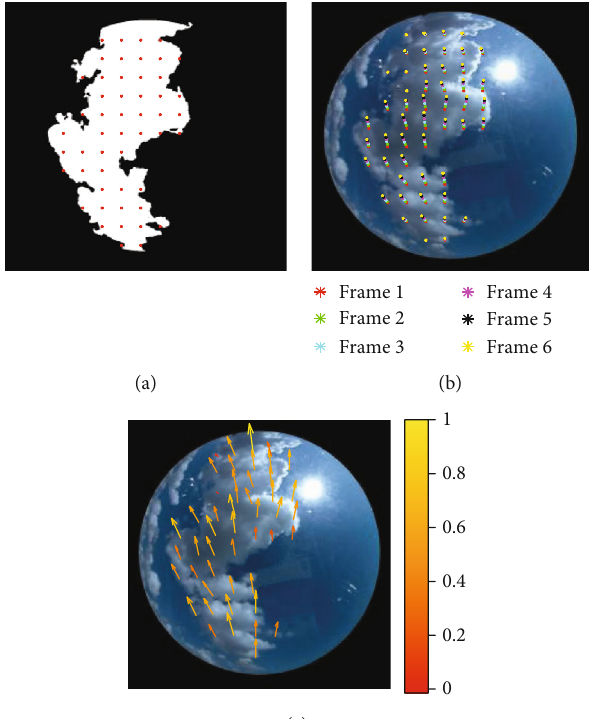
Figure 12: (a) Selected points inside a cloud, (b) tracked points over a 1 minute, and (c) mean of the motion vectors of the selected points.